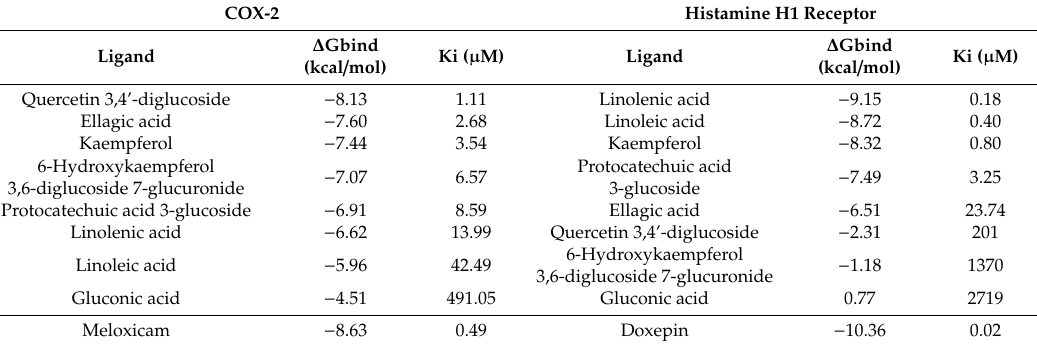
Table 3. Free-binding energies ( ∆ Gbind in kcal / mol) and inhibition constant (Ki, in µ M) obtained by molecular docking of the compounds identified in the EHPC hydroethanolic extract with the COX-2 structure and H1 histamine